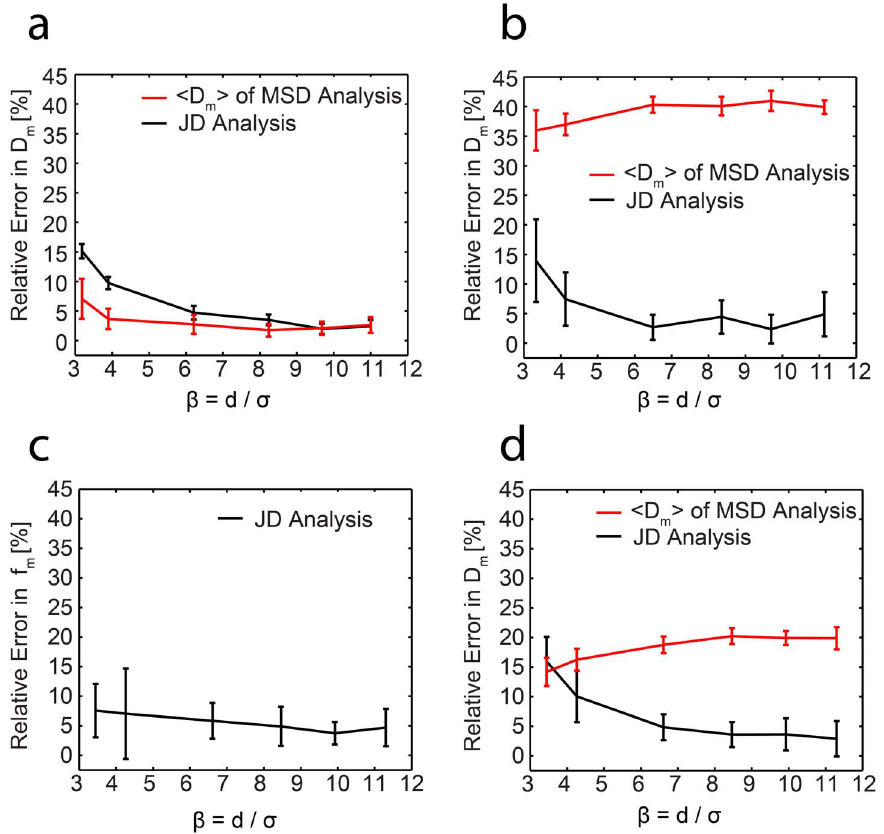
Figure 4. Comparison of JD analysis and MSD analysis on simulated data. Simulations with varying mobile and immobile populations were used to compare the performance of the JD analysis (black curves) to the standard MSD approach (red curves). (a,b,d) The results shown are the relative error | D m, (output) 2 D m, (ground truth, GT)|/D m (GT) in the diffusion coefficient of the mobile population as a function of the parameter b and (c) the relative error |f m (output) 2 f m (GT)|/f m (GT) in the mobile fraction as a function of the parameter b . All results are the mean values of 10 repetitions, with each repetition based on the analysis of 750 simulated trajectories. Error bars represent 6 1 standard deviation (a) All particles belong to the mobile population. (b,c) 50% of the particles are mobile, and 50% immobile (d) 50% of particles undergo a motion change (mobile R immobile).